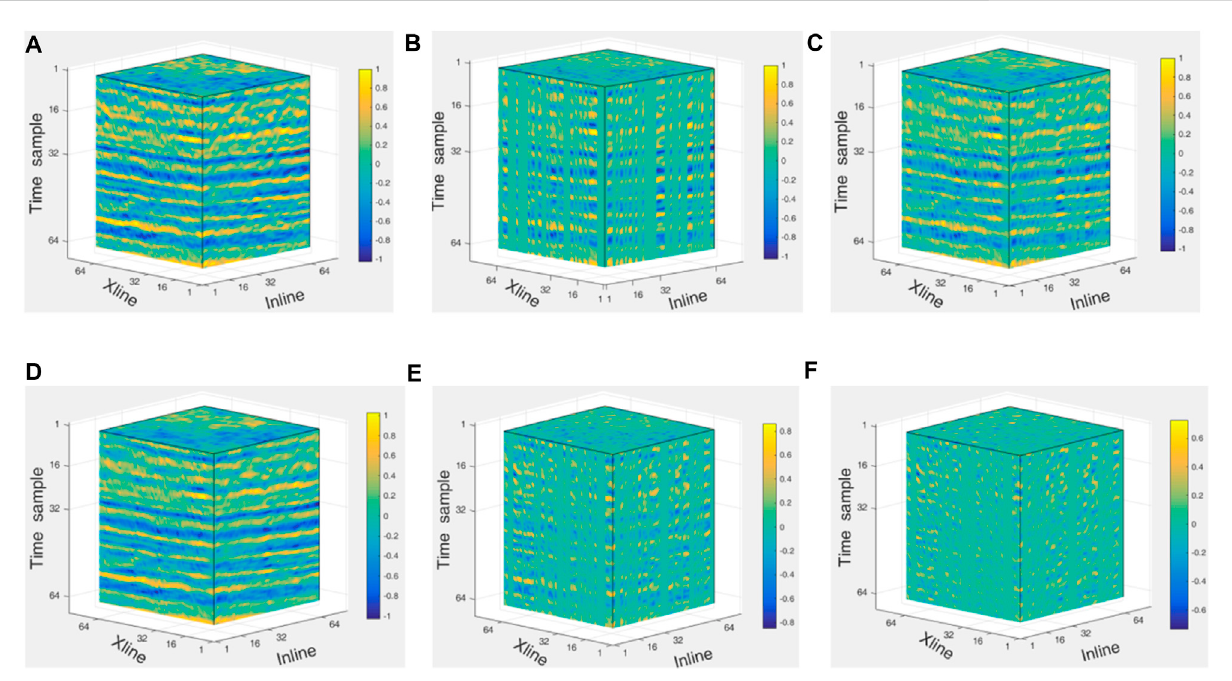
FIGURE 9 Reconstruction results of three-dimensional fi eld data in the curvelet domain. (A) Original data; (B) 51% of randomly missing data; (C) interpolated data obtained by the FISTA method; (D) interpolated data obtained by the SFISTA method; (E) reconstructed errors obtained by the FISTA method; (F) reconstructed errors obtained by the SFISTA method.